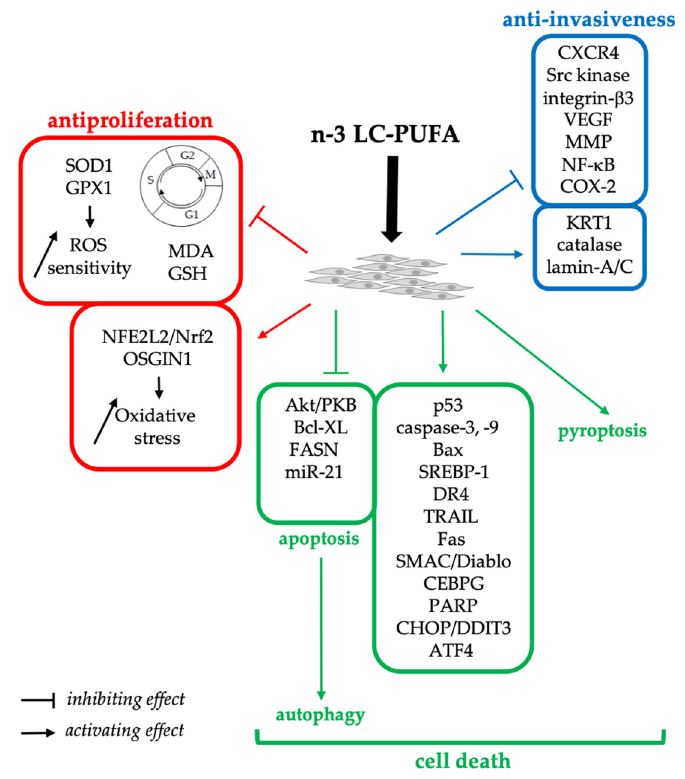
Figure 1. Antiproliferative (red), pro-apoptotic (green), and anti-invasive (blue) effects of n-3 LC- PUFA on human breast cancer cell lines. This figure summarizes different markers of target genes or proteins and signaling pathways involved in the regulation of mechanisms involved in the inhibition of breast cancer development. MDA, malondialdehyde; GSH, reduced glutathione; ROS, reactive oxygen species; other abbreviations are gene/protein names.